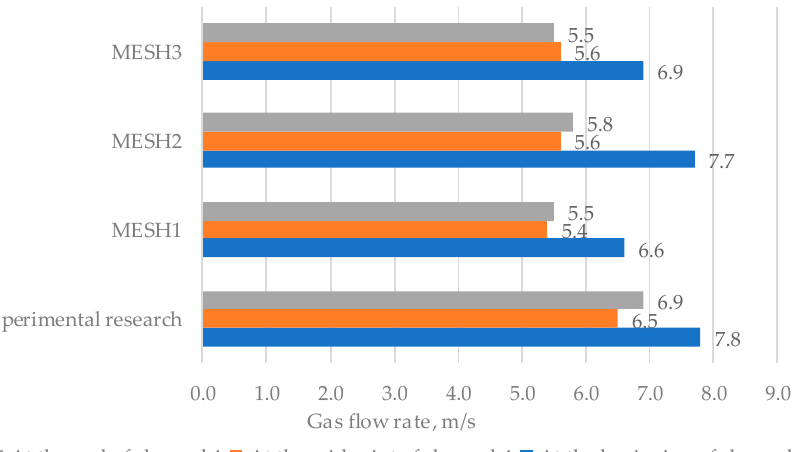
Figure 4. The results of the comparative analysis of the gas flow rates in channel 4 of the cyclone separator obtained based on the experimental data and numerical simulation using k ‐ ω SST viscosity model, using the computational meshes with various degrees of detailed elaboration.